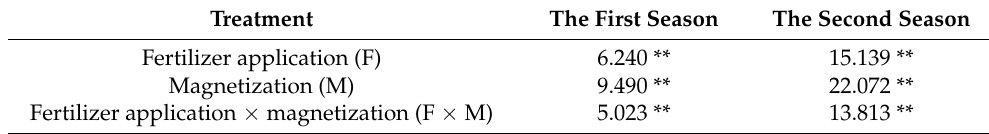
Figure 2. Dry weight of clogging substances in the emitter under different treatments in the first season (1) and the second season (2). * indicates p < 0.05, ** indicates p < 0.01. Table 3. The effects of fertilizer application and magnetization on the DW under different seasons.